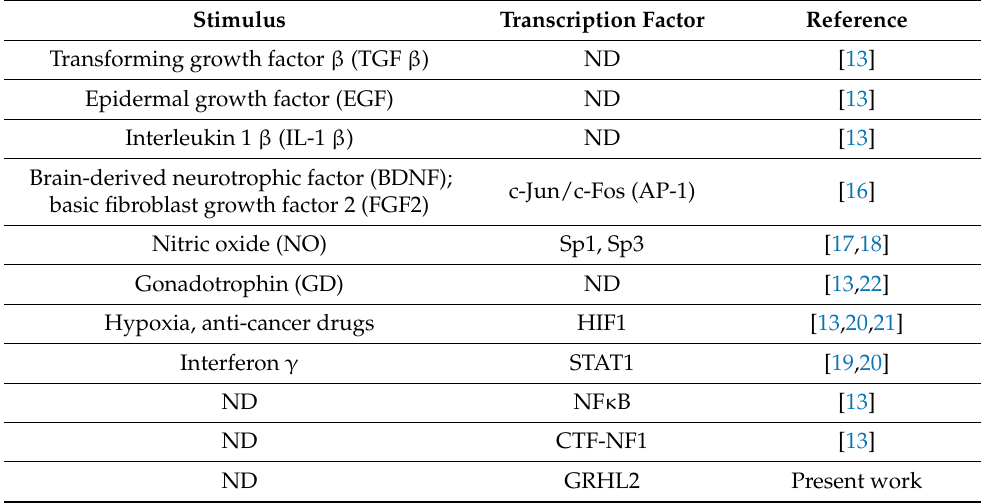
Table 1. Stimuli and transcription factors which influence S100A10